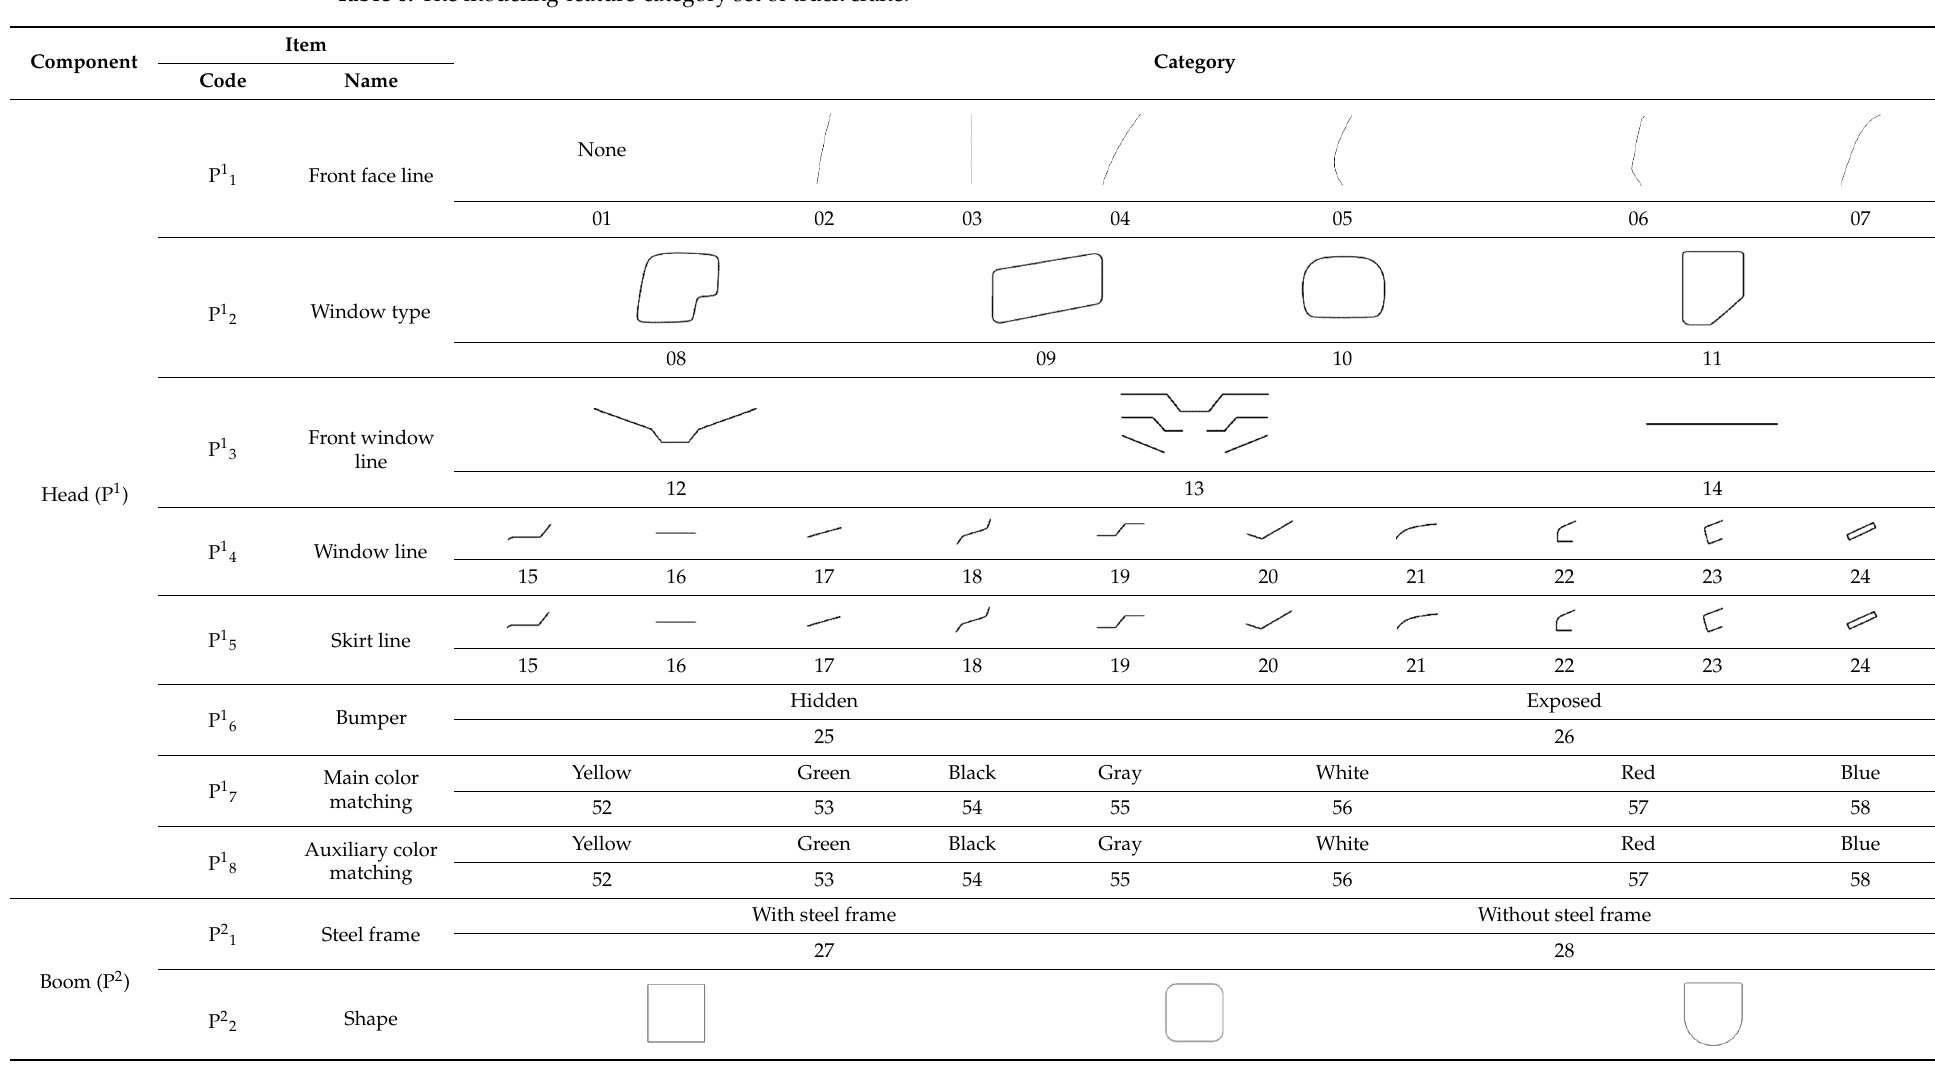
Table 6. The modeling-feature-category set of truck crane.